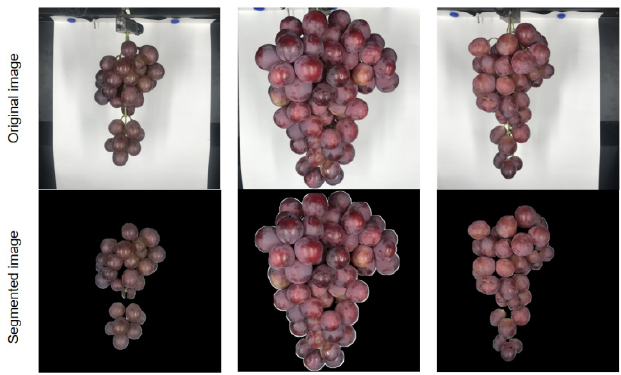
Figure 2. Grape semantic segmentation images using U-Net.